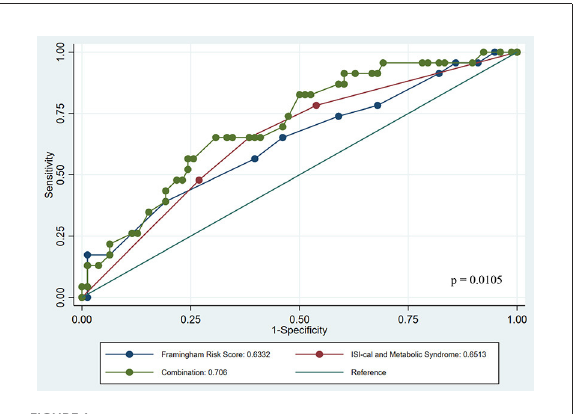
FIGURE1 Receiver Operator Curve comparing role of risk stratification scores across Framingham risk, ISI-cal and Metabolic Syndrome separately and